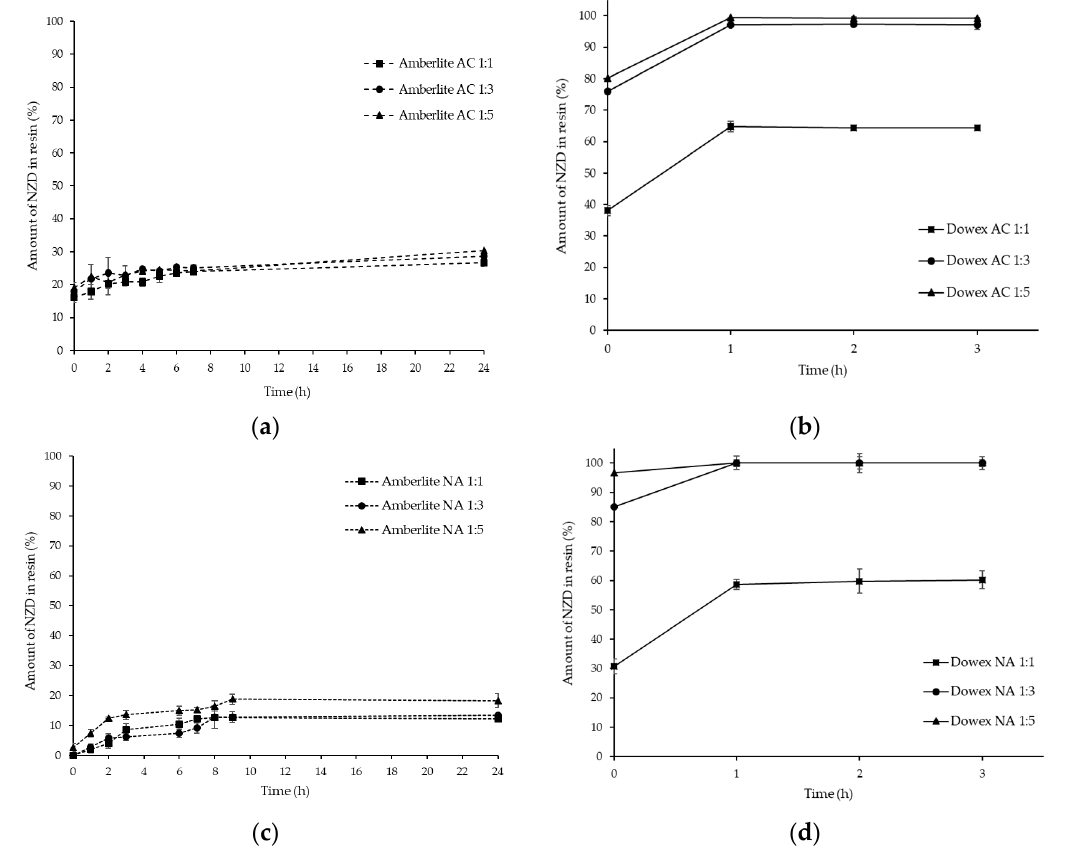
Figure 2 . Optimization of drug and resin at 1 : 1, 1 : 3, and 1 : 5 ratios of nizatidine (NZD)-activated Figure 2. Optimization of drug and resin at 1:1, 1:3, and 1:5 ratios of nizatidine (NZD)-activated Amberlite complex ( a ) , NZD-activated Dowex complex ( b ) , NZD-inactivated Amberlite complex ( c ) , Amberlite complex ( a ), NZD-activated Dowex complex ( b ), NZD-inactivated Amberlite complex ( c ), and NZD-inactivated Dowex complex ( d ). and NZD-inactivated Dowex complex ( d